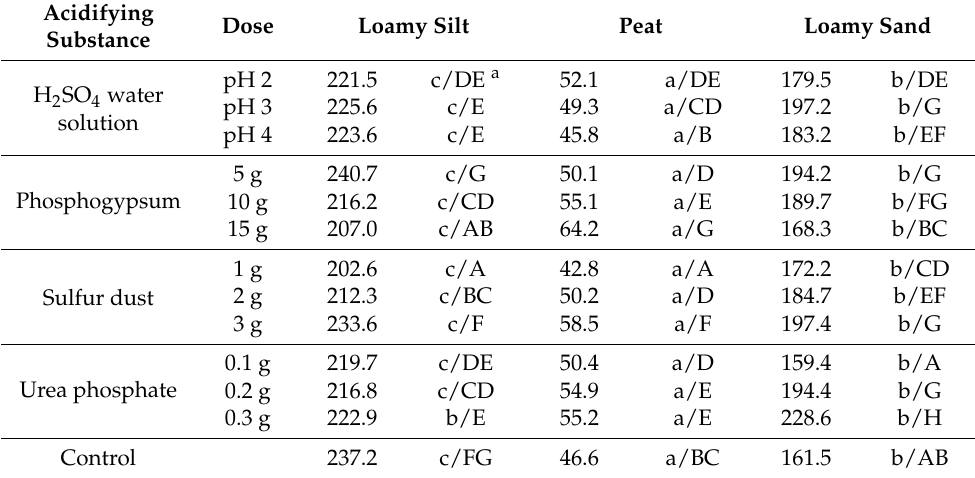
Table 9. Effects of acidifying substances after 12 months on the content of available manganese in loamy silt, peat and loamy sand